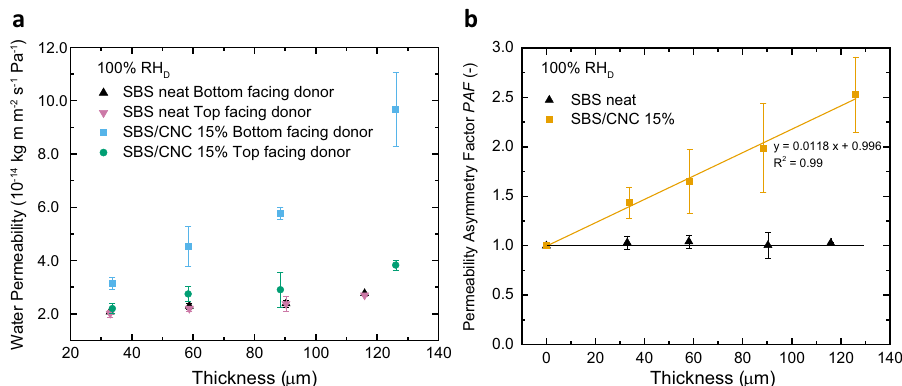
Fig. 3 Asymmetric water permeability of compositionally graded SBS/CNC membranes. Plots of a the impact of membrane thickness on water permeability and b the corresponding permeability asymmetry factor (PAF) of membranes made from neat SBS and SBS/CNC 15 wt% using the wet cup gravimetric method (RH D = 100%) (data from a ). All experiments were conducted at 25 °C. Reported values are the mean ± s.d. of n = 3 measurements from